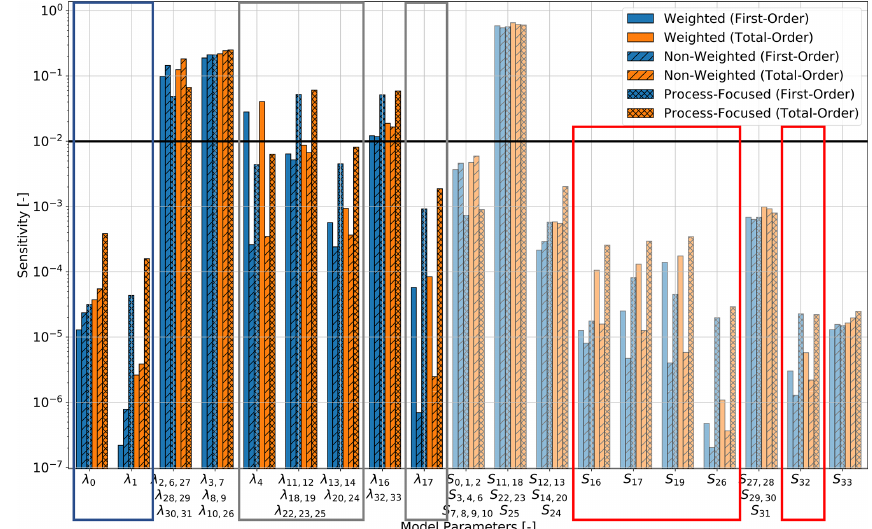
Figure 10. Top-level sensitivity analysis (focusing on the entire Alps model) with different weighting schemes of the hierarchical global sensitivity analysis for the General-Focus Alps model. For the layer IDs and symbols, please refer to Table A1. The solid black line denotes the threshold value for determining if the parameters are influencing the model response.